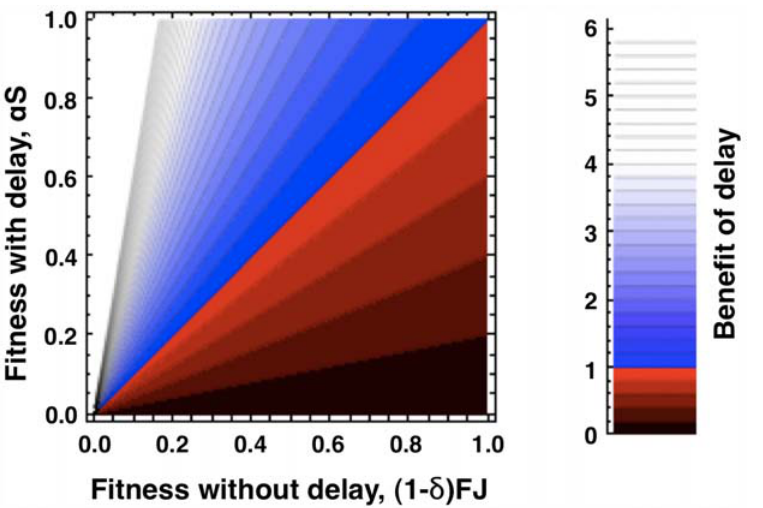
Figure 1. Fitness consequences of reproductive delay during population decline. An initially rare genotype (FD) that facultatively delays reproduction during a bad year is evolutionarily favored (blue shading) when a S , the increased fecundity of older individuals, reduced by the chance of dying before second-year reproduction, is greater than the overall change (decrease) in population size. This change, (1 2 d )FJ , is also the reproductive success of the initially predominant annual genotype (A). This fitness landscape does not change regardless of whether conditions are better next year or not, demonstrating that the fitness benefit of delay is due, not to an increase in fecundity with improved conditions, but rather to an increase in the proportional representation of FD in a shrinking